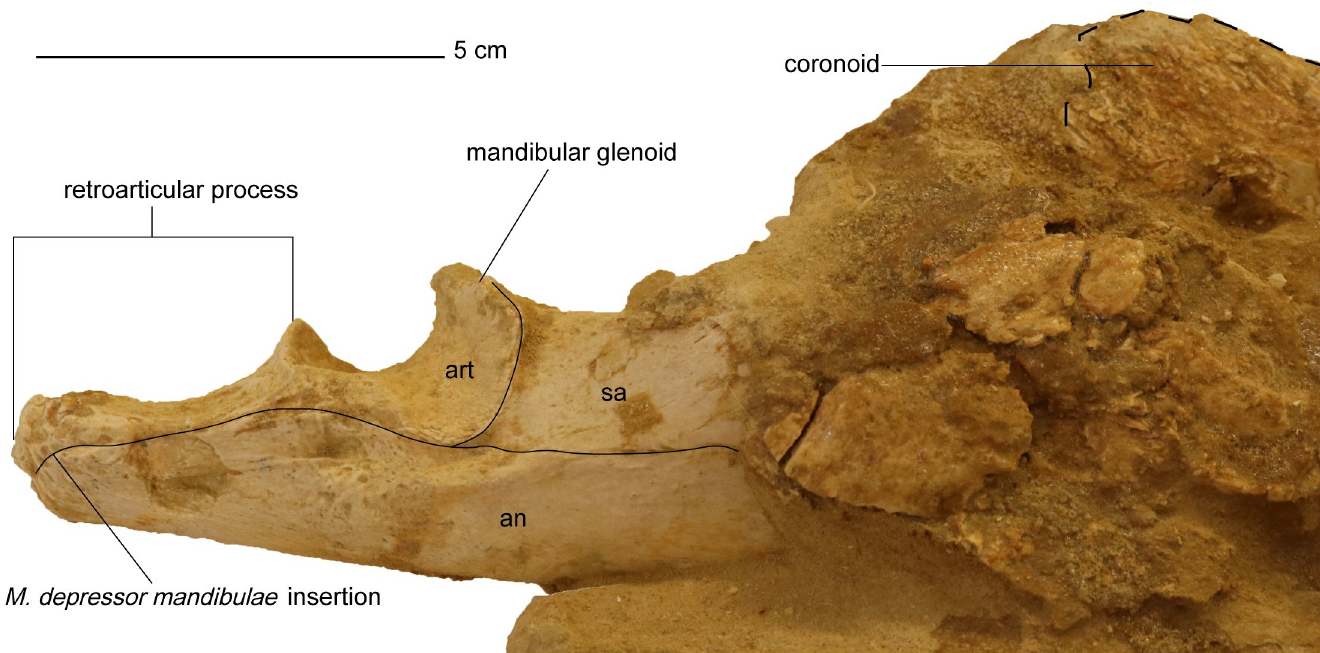
Fig 14. Right retroarticular process and mandibular glenoid of Cardiocorax mukulu (MGUAN PA278).